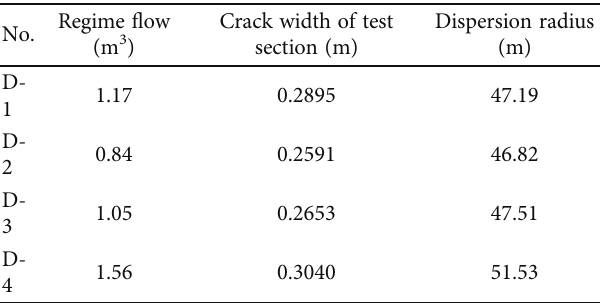
Table 6: Table of maximum di ff usion radius in PPT.